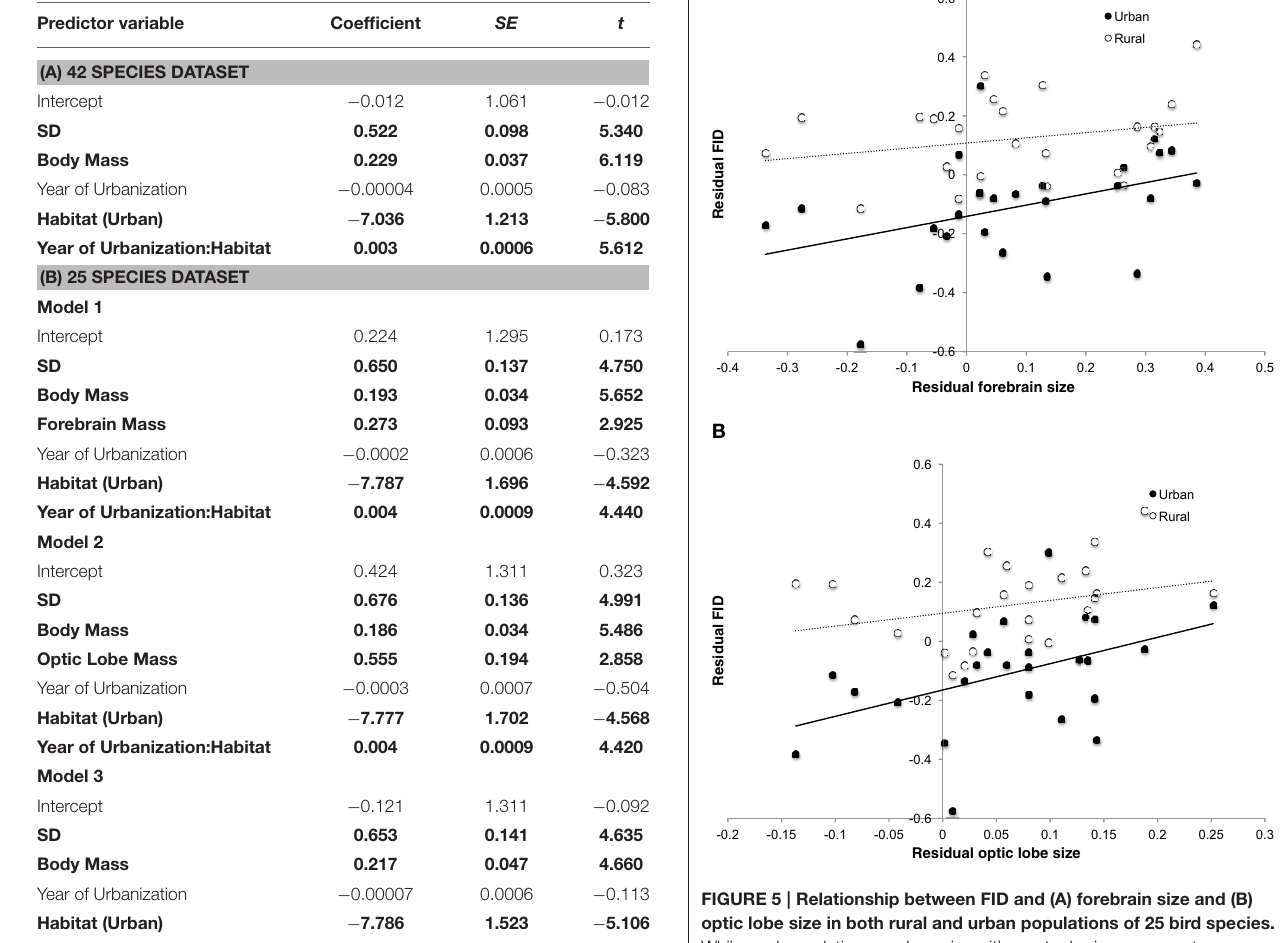
TABLE 4 | Parameter estimates from models with 1 AICc < 2, explaining variation in FID among birds. Predictor variable